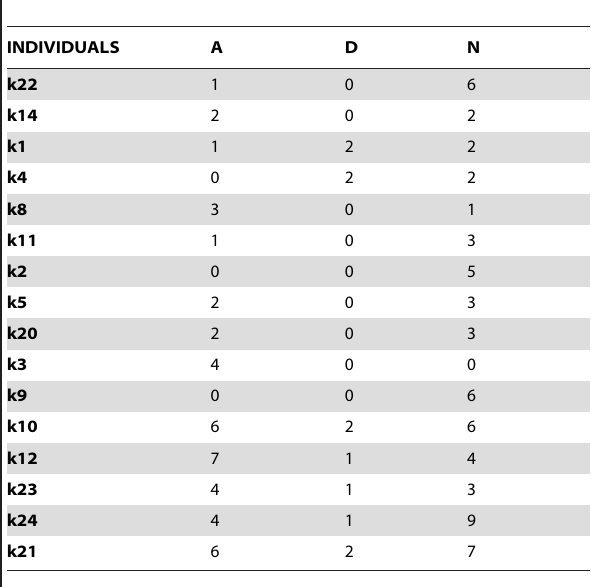
Table 3. The number of attracted (A), dispersed (D), and neutral (N) pairs per